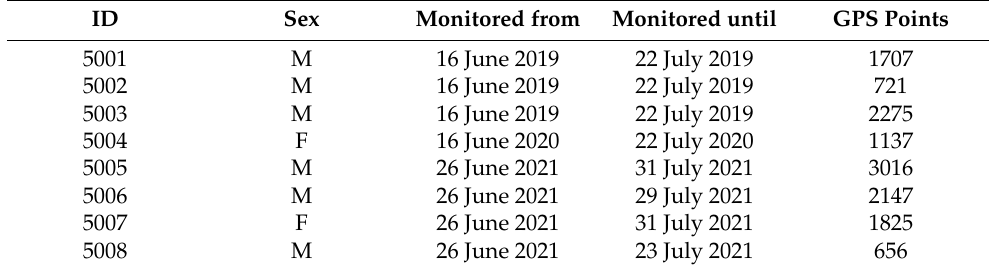
Table 1. Data of the GPS-tracked red-footed